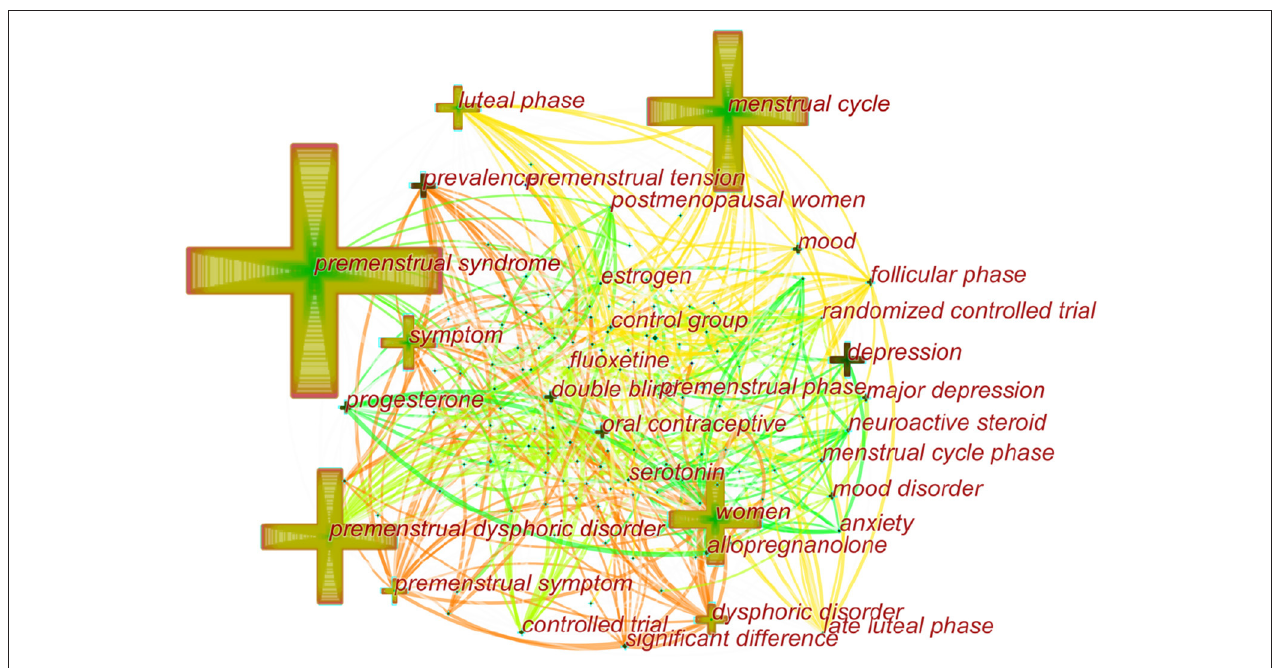
FIGURE 9 | Map of keywords that published articles on PMS/PMDD during 1950–2018.